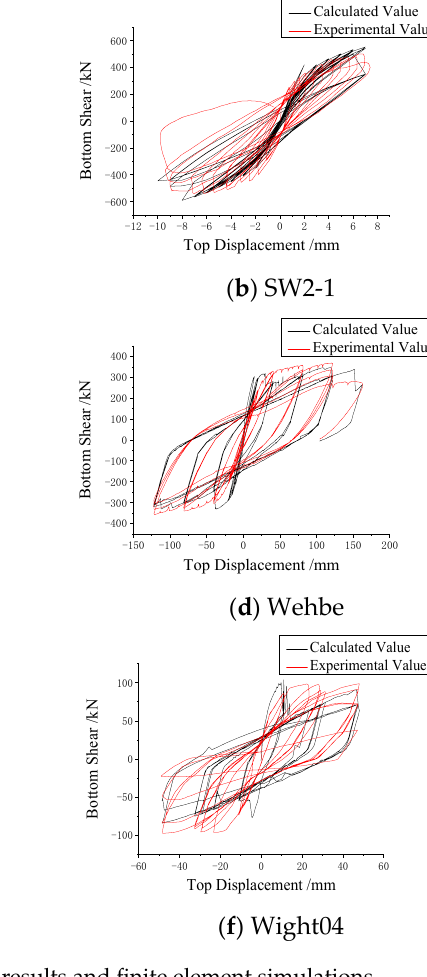
Figure 2. Comparison between experiment results and finite element simulations.